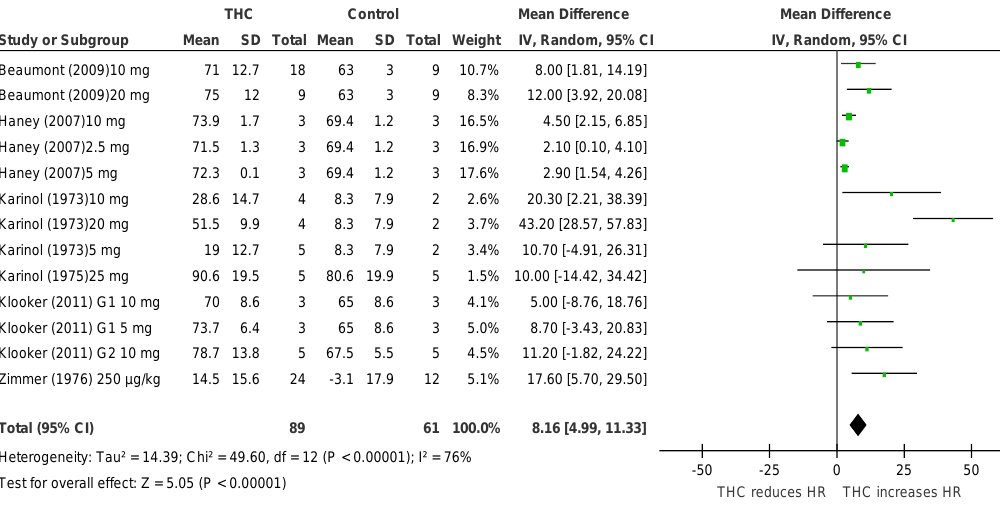
Figure 6. Changes in HR induced by acute THC dosing in humans.